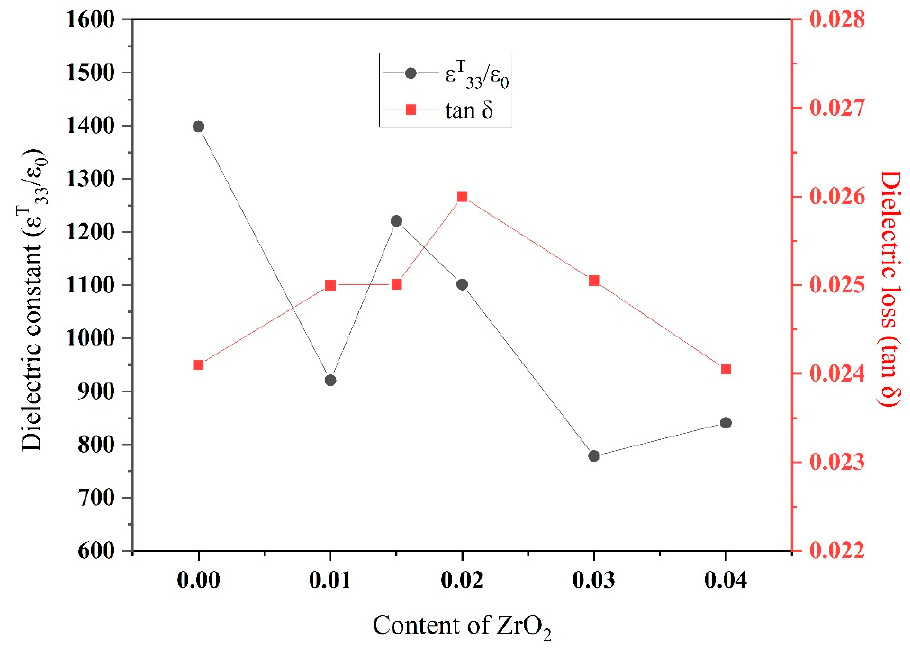
Figure 9. Variation in ε T 33 / ε 0 and tan δ with ZrO 2 content in PZTN nanocomposite ceramics sintered at 1260 °C for 2 h.